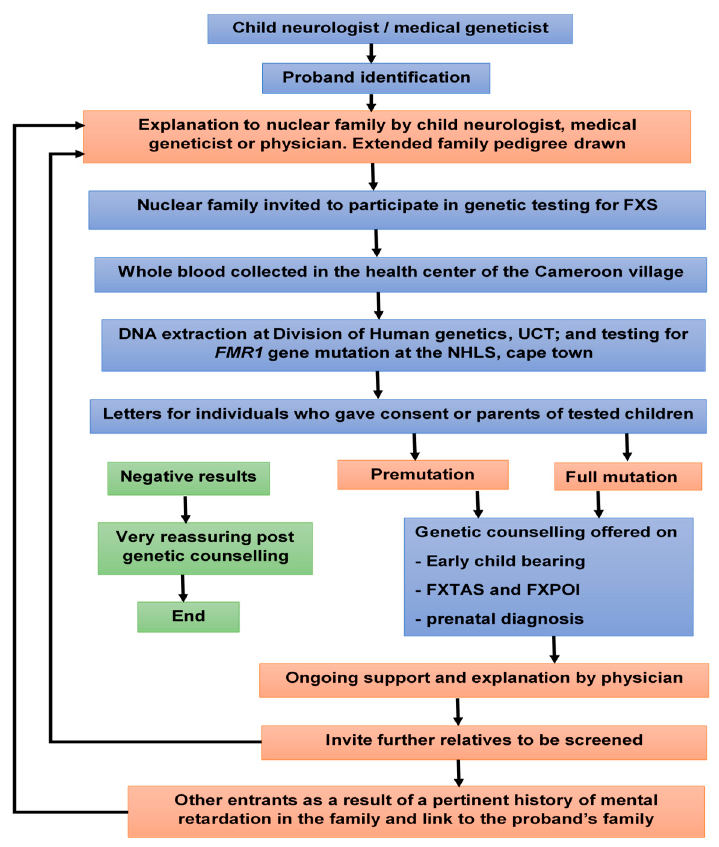
Figure 1. Flow chart of cascade testing for Fragile X Syndrome in Cameroon.